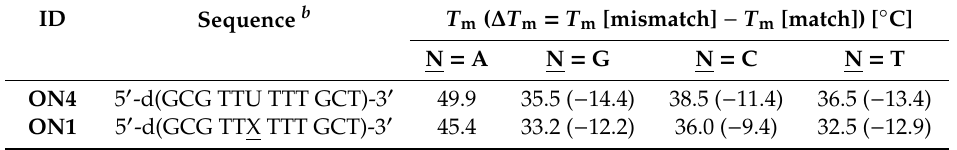
Table 4. Mismatch discrimination of natural and OxNorNA-modified oligonucleotides toward ssDNA a